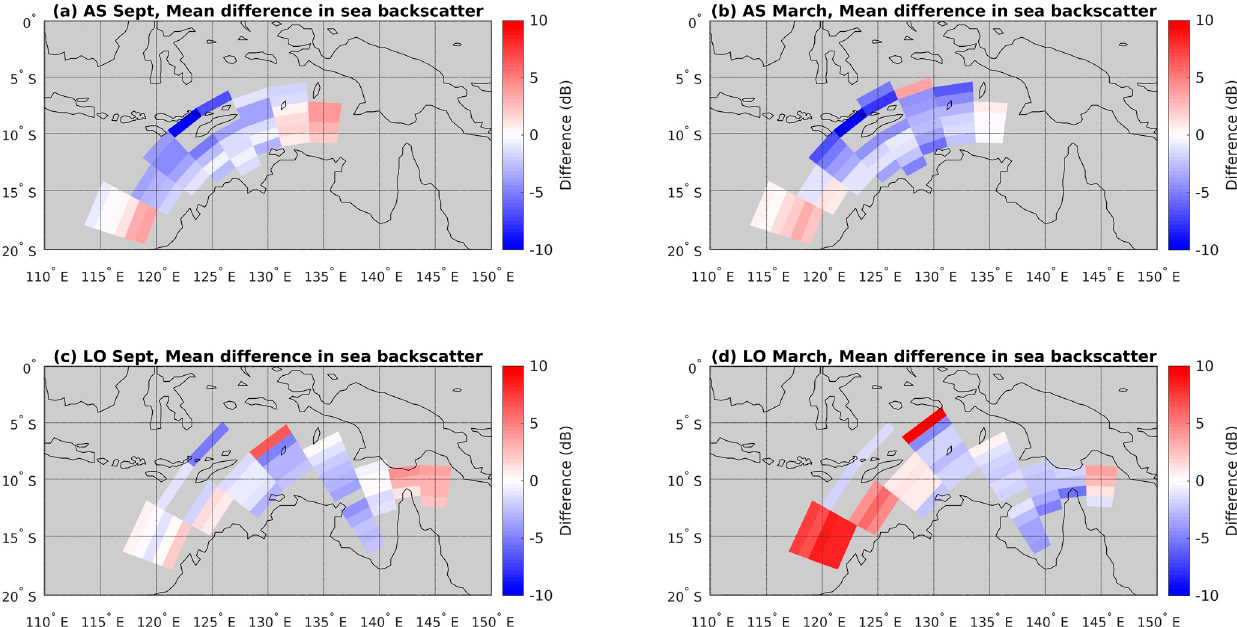
Figure 8. Mean difference between the Barrick method and the backscatter ionogram method backscatter coefficients. The difference between the methods was calculated when data were available throughout a month, then the mean difference was calculated. The backscatter coefficients for each method from all times in both September 2015 and March 2016 and all range-azimuth cells were plotted against each other as 2D histograms for each sounder (shown in Figure 9). The total number of data points in the Longreach histogram and the Alice Springs histogram are 2907 and 3457. If the two methods produced similar results, it is expected that these 2D histograms would show a linear relationship with a slope of one that passed through the origin. This linear trend could be seen, although the slopes and intercepts did not match this relationship. A Pearson correlation test was conducted to test the linear correlation between the results from the Barrick and the backscatter ionogram methods. This tested the null hypothesis that there was no relationship observed between the results. The strength of the correlation is represented by the absolute value of the correlation coefficient and the direction by the sign of the correlation coefficient. The significance level was given by the P value. For these tests, the P values were less than 0.001, so the corresponding correlation coefficients were considered significant at greater than the 99% confidence interval. The correlation coefficients for Alice Springs and Longreach were 0.51 and 0.53, respectively. This indicates there is a moderate positive linear relationship in the results from the two methods of calculating the sea surface backscatter coefficient. A line of best fit was fitted using an orthogonal least squares linear regression method (Figure 9). This method was chosen over a simple linear regression as errors in both the variables are considered, rather than using one variable to predict the other. For both sounders, the slope was greater than 1 and the intercept was positive which suggested differences between the two methods. The slope of the fitted line in the Alice Springs and Longreach results was 2.5 and 1.5, respectively. Using these fitted lines, the ionogram comparison and wave spectrum methods produced the same results when the backscatter coefficient was − 27.3 and − 28.6 dB for the Alice Springs and Longreach sounders, respectively. The slopes of both fitted lines were greater than one which suggested that the backscatter coefficients from the Barrick method had a greater dynamic range than those from the ionogram method.